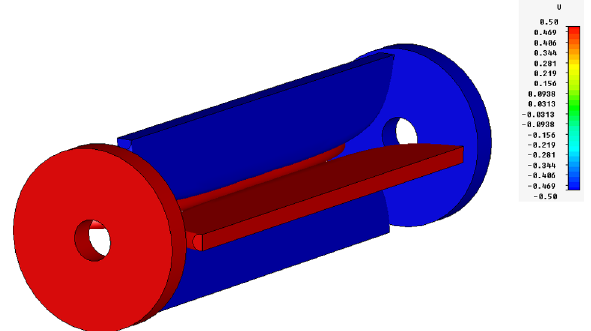
FIG. 13. EM-Studio model: Voltage applied to the vane tips and the flanges to simulate the longitudinal field in the gap between the flange and the vanes.